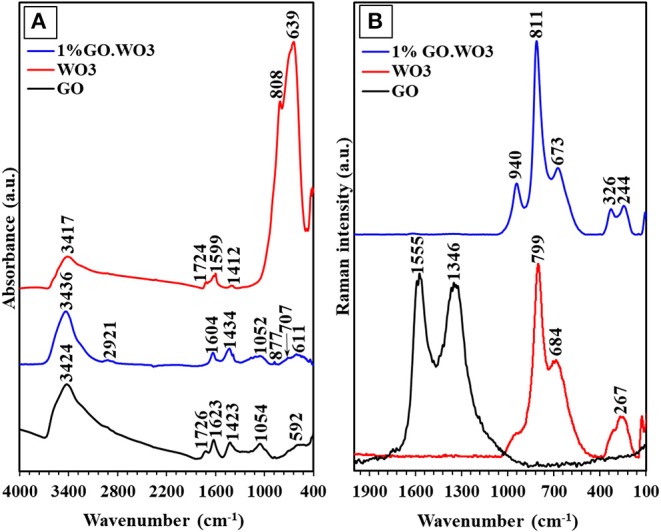
FTIR spectra (A) and Raman spectra (B) of GO, WO3, 1%GO.WO3 catalysts.